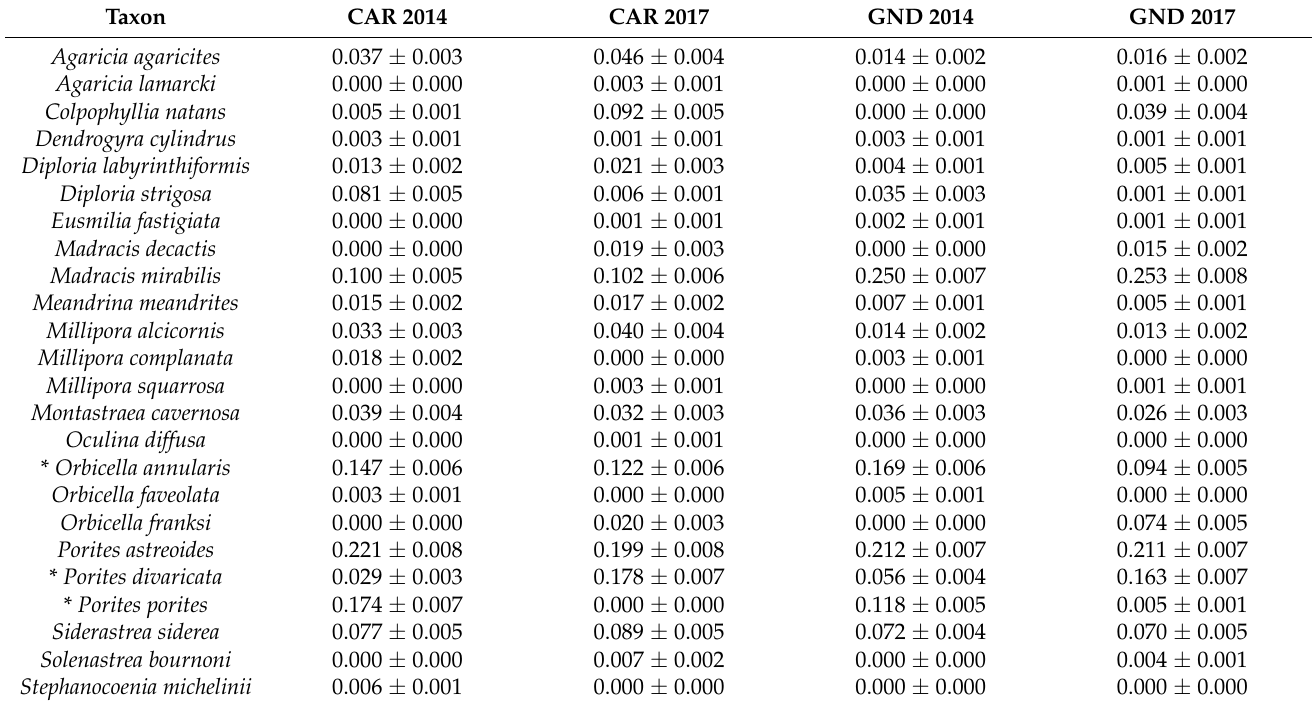
Table 3. Mean ( ± SD) relative proportion of hard coral species colony counts in Carriacou (CAR) and Grenada (GND) in 2014 and